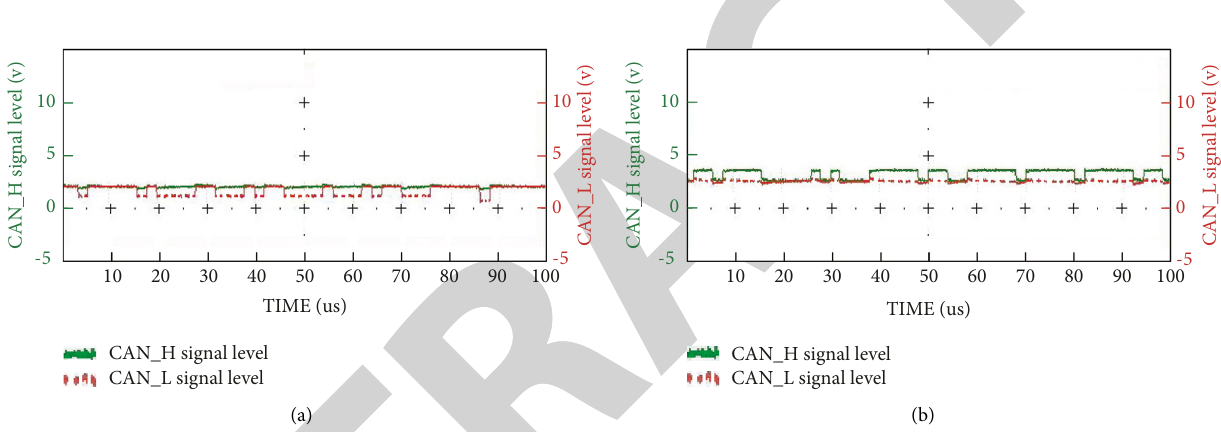
Figure 8: Signal waveform under the conditions of CAN_H or L being disconnected. (a) PT-CAN_H wire open circuit. (b) PT-CAN_L wire open circuit.